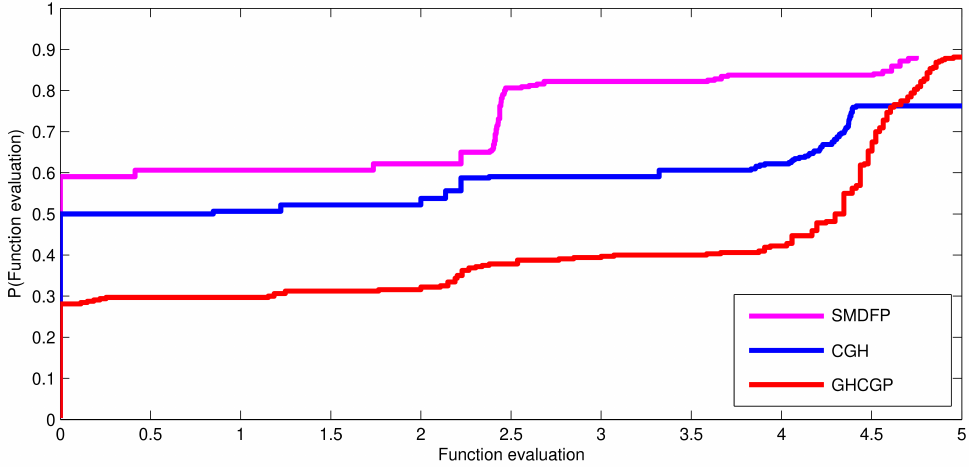
Figure 2. Performance of the SMDFP, CGH [61], and GHCGP [62] methods for the number of function evaluations.